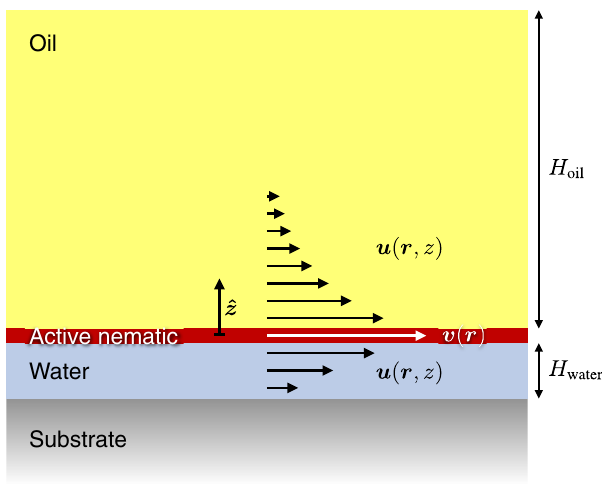
FIG. 5. Schematic of the experimental setup and flow fields (side view). The thicknesses of the fluid layers are not to scale. The actual thickness of the active nematic film is h ≈ 2 μ m, ≈ whereas the thicknesses of the passive fluid layers are H water 40 μ m and H ≈ 3 mm. We treat the active nematic as a two- oil dimensional film. White and black arrows represent the flow fields in the active nematic film and in the passive fluid layers, respectively. The flow is planar and it penetrates into the oil and water layers. Here, we represent flow penetration according to Eq. (B9) for a planar wave number q= ð 2 π Þ ¼ 5 × 10 − 3 μ m − 1 , which lies in the range of our experimental